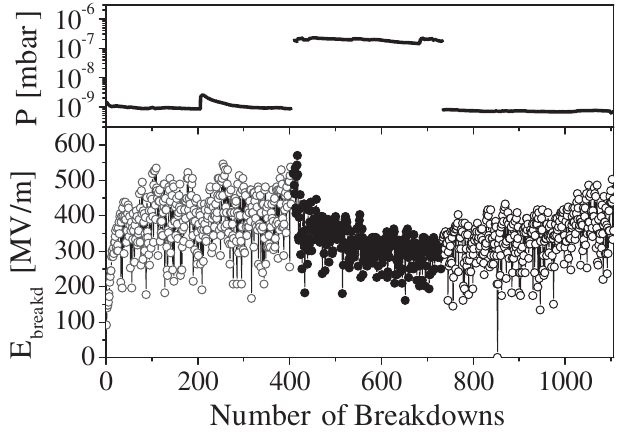
FIG. 2. Breakdown fields for molybdenum, and the effect of , as function of the accumulated number of breakdowns. pure O 2 The lower graph shows the breakdown conditioning curve for molybdenum, where the vertical axis denotes the maximum achieved applied electric field in MV = m before